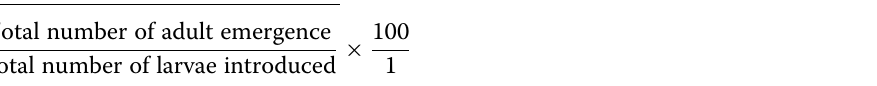
(Odeyemi and Daramola 2000).